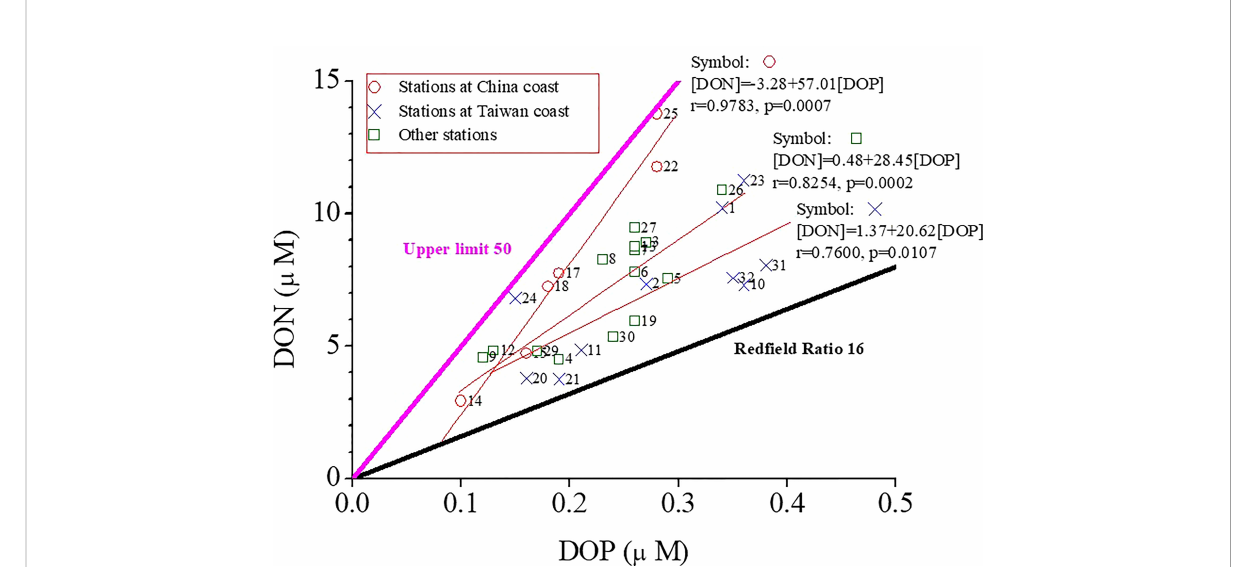
FIGURE 6 Scatter plots of DON and DOP concentrations in TS surface waters in early summer. The DON : DOP ratios ranged from 16 (Red fi eld ratio) to 50 (upper limit) and were roughly grouped as three ratios (20.62 [×], 28.45 [ □ ], 57.01 [ ○ ]), increasing from the coast of Taiwan (20.62) to the coast of China